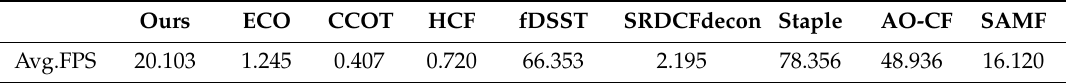
Table 1. The speeds in comparison of di ff erent trackers on the OTB-2013 dataset. Ours ECO CCOT HCF fDSST SRDCFdecon Staple AO-CF SAMF Avg.FPS Table 2. The speeds in comparison of di ff erent trackers on the OTB-2015 dataset. Ours ECO CCOT HCF fDSST SRDCFdecon Staple AO-CF SAMF